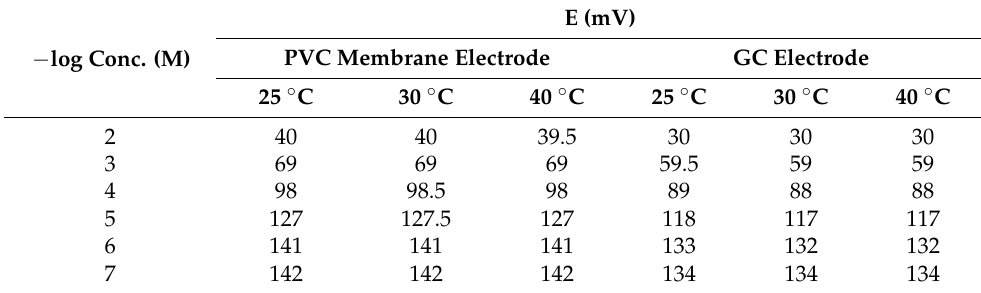
Table 3. Profile of the potential versus –log concentration for the PVC membrane electrode and the GC electrode, at three temperatures (25 ◦ C, 30 ◦ C, and 40 ◦ C) at pH 9.